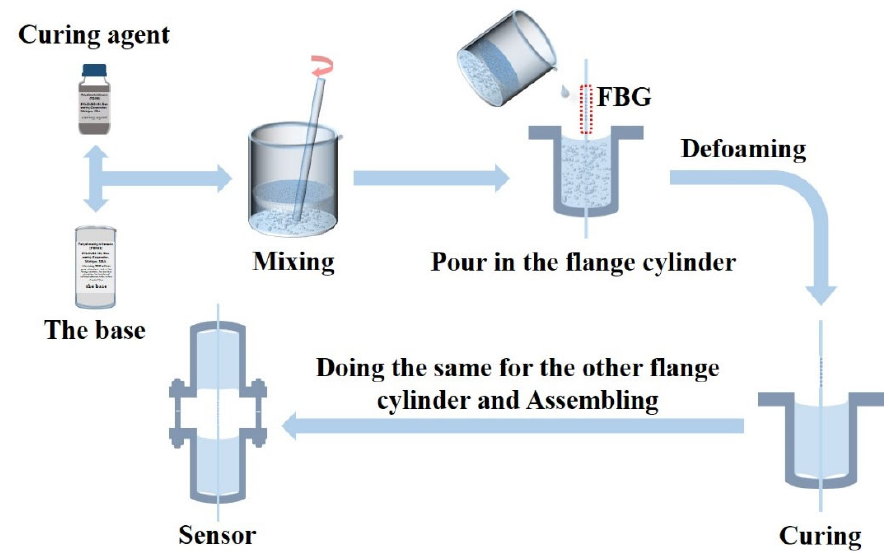
Figure 4. Fabrication process of the proposed sensor.